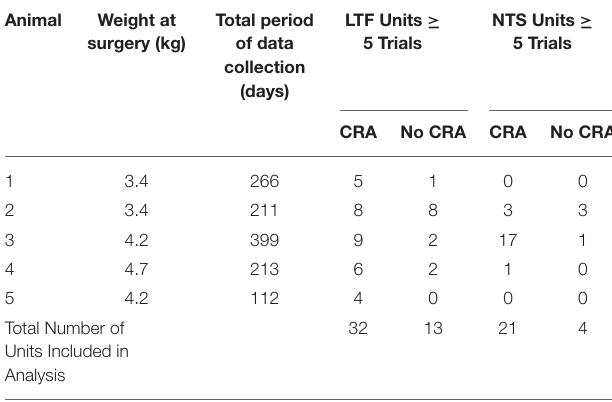
TABLE 1 | Information about the animals used in the study, the length of data collection, and the number of units included in data analysis. Animal Weight at surgery